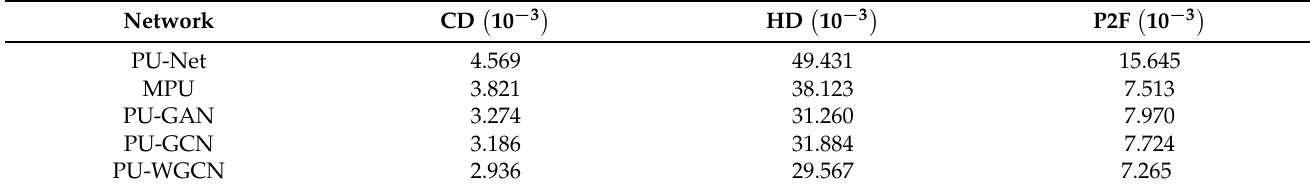
Table 1. Comparison of upsampling results for point cloud numbers from 256 to 1024.